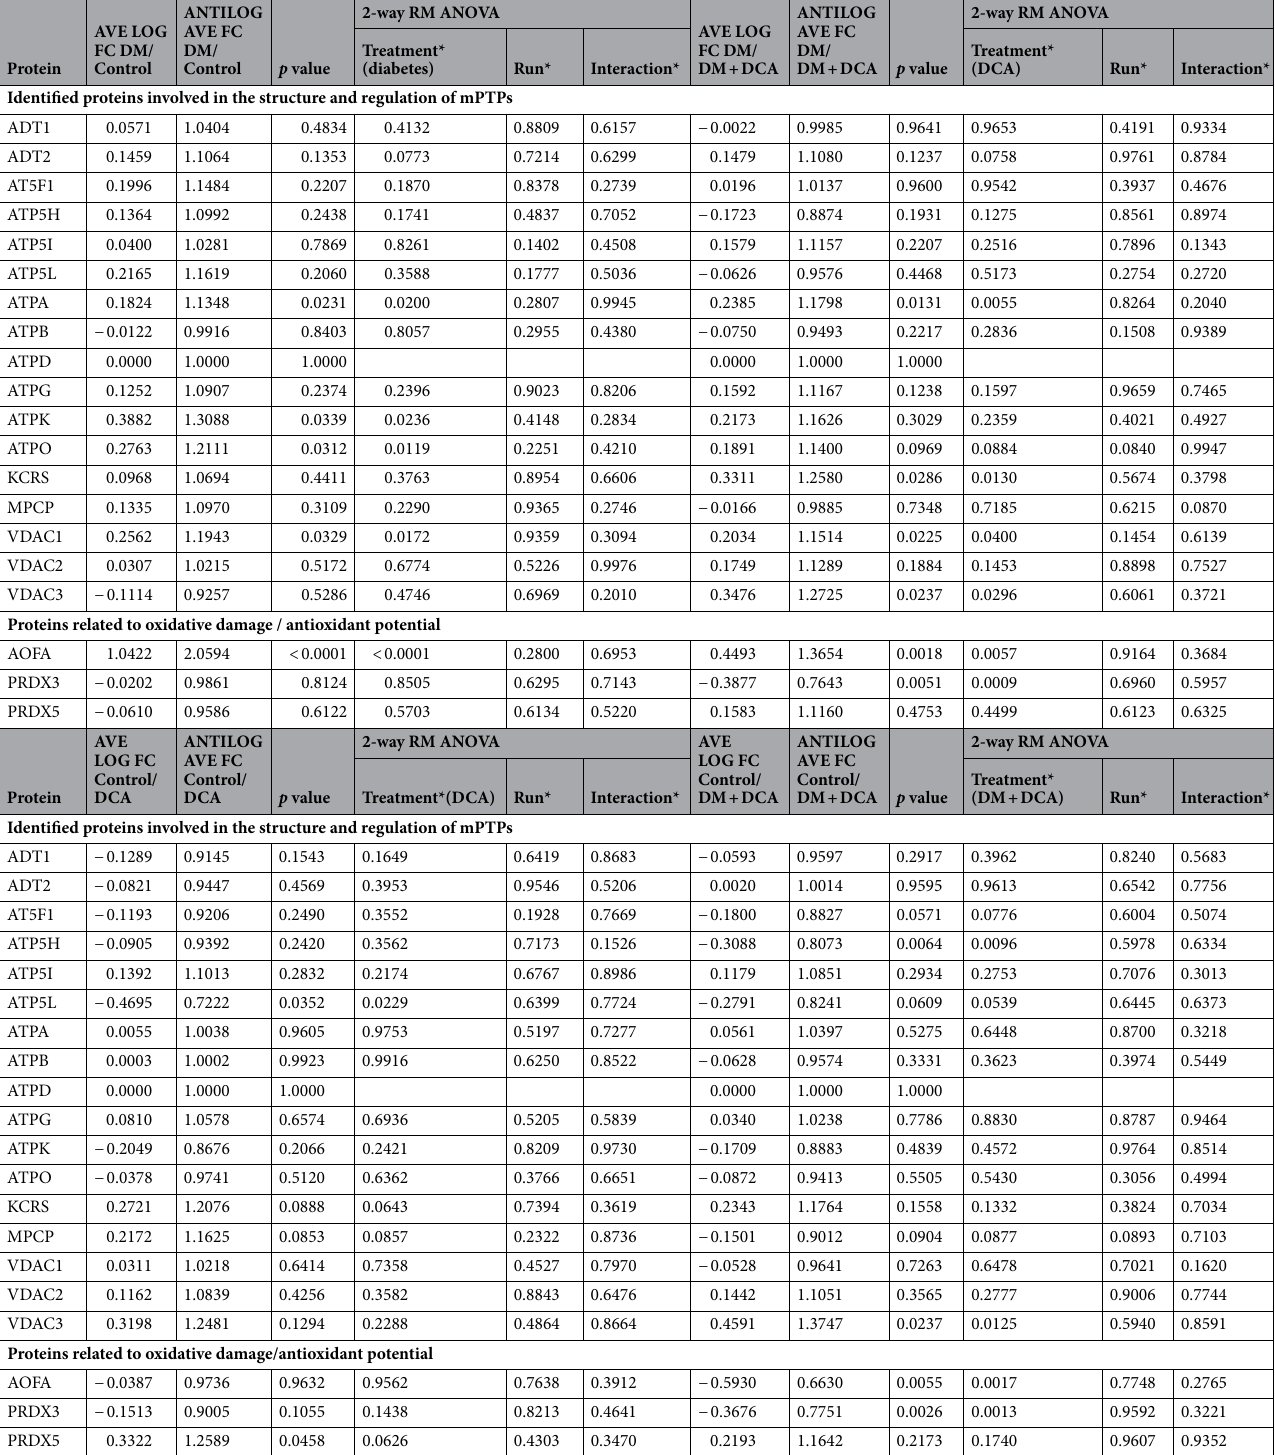
Table 2. Analysis of the treatment effects on the logarithmic scale. * p value from testing the hypothesis of no difference in log emPAI values for the indicated sources of variation compared to random variability. FC fold change; AVE average; P: probability; RM repeated measures; AOFA amine oxidase [flavin-containing] A; PRDX3 thioredoxin-dependent peroxide reductase; PRDX5 peroxiredoxin 5. Names and abbreviations of the proteins involved in the structure and regulation of mPTPs are in the legend of Fig.